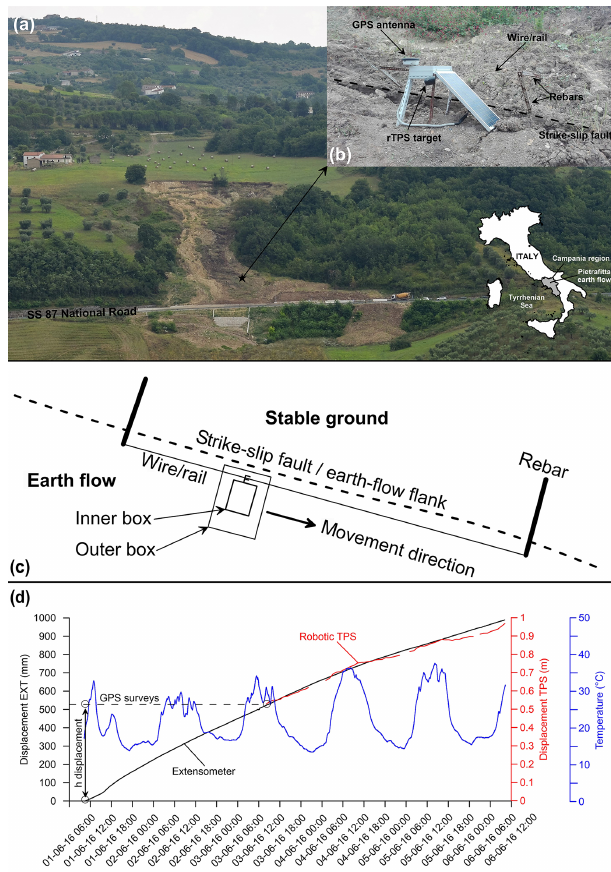
Figure 3. (a) The Pietrafitta earth flow in the Appenine moun- tains of southern Italy, Campania region. The black star indicates the position of the extensometer during the field test. (b) Installa- tion configuration and monitoring equipment for comparative anal- ysis. (c) Installation scheme. (d) Results of displacement monitor- ing with the extensometer and comparison with GPS derived and rTPS results. Black circles indicate error associated with GPS sur- veys. Operating temperature measured by the extensometer is also shown.